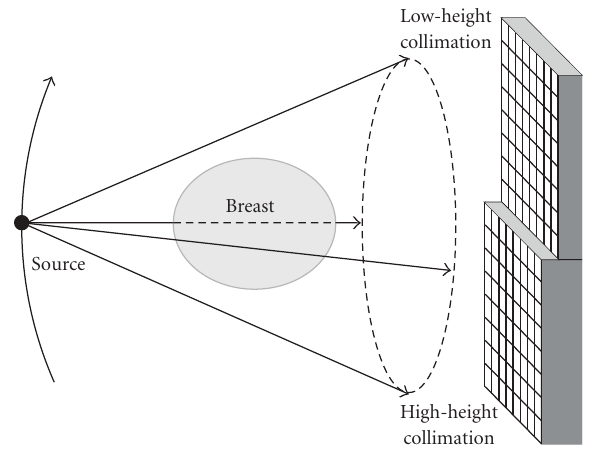
Figure 1: Single pass cone-beam circular scan with a dual collimation detector array for both dark-field tomography and transmission X-ray CT